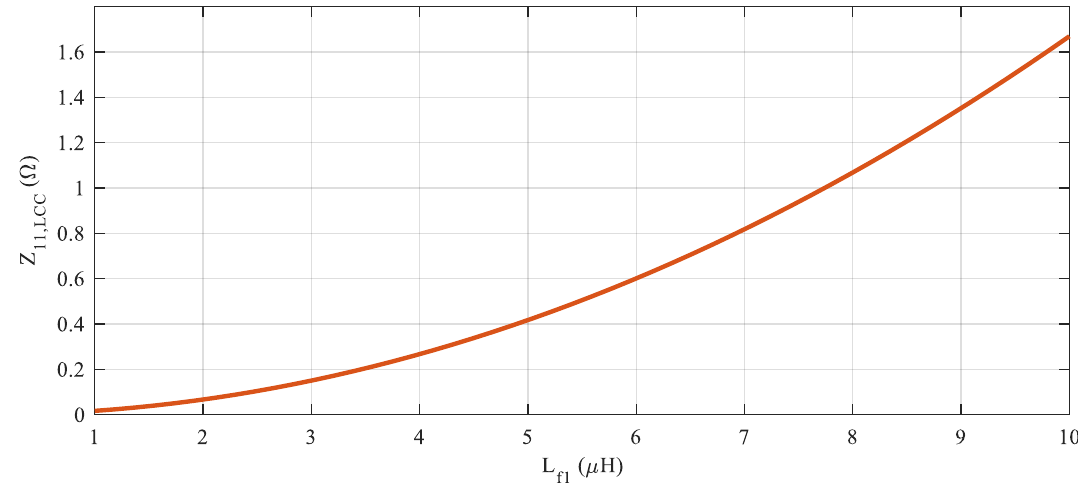
Figure 3. Input impedance Z 11 ’,LCC versus inductance L f 1 (class Z3, aligned coils with the configuration shown in Section 5 in Figures 4 and 5).